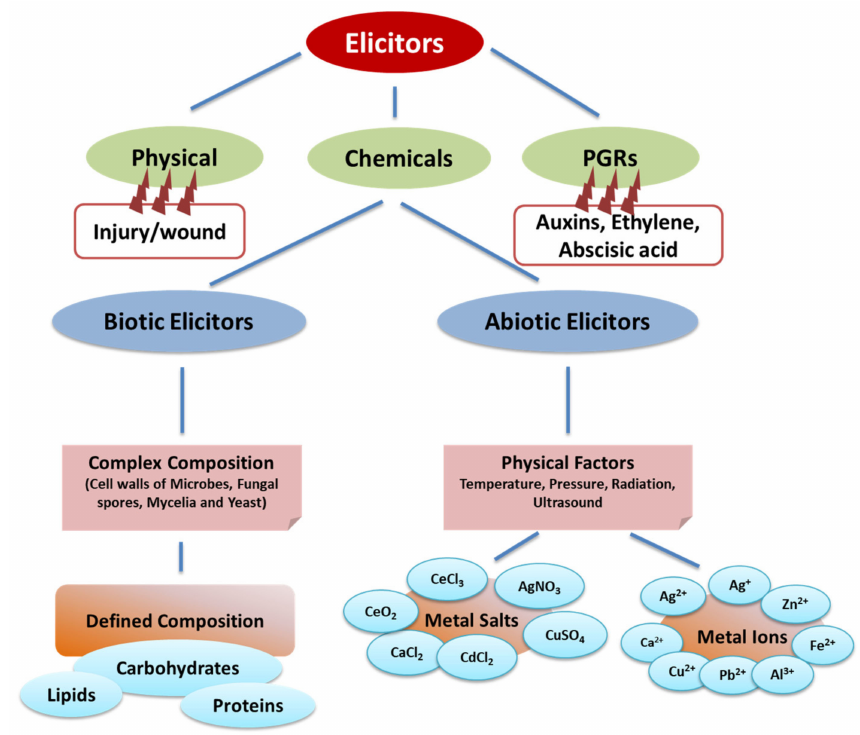
Figure 2. Strategies to improve phyto-constituents in adventitious root cultures. A wide variety of elicitors were employed to alter cell metabolism in order to en- hance the production of secondary metabolism in plant-cell cultures. Bis-carboxyethyl germanium sesquioxide was used as an elicitor to enhance the biomass and ginsenoside productions [122]. The effects of methyl jasmonate (MJ) and salicylic acid (SA) on the production of tropane alkaloids and the expression of putrescine N -methyltransferase and hyoscyamine 6 β -hydroxylase were studied in adventitious root cultures of Scopolia parviflora [123]. The effects of CuCl 2 and glutathione on phytochelatin (class III methalloth- ioneins) induction and the increased production of anthraquinone pigments were studied in Rubia tinctorum [124]. Methyl jasmonate and salicylic acid as an elicitor improved the productivity of withanolides in the adventitious root culture of Withania somnifera [125] (Table